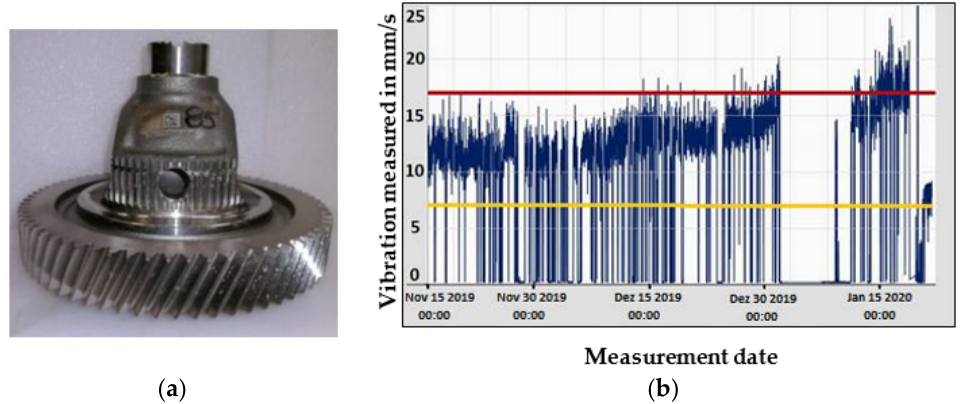
Figure 7. Renault Cacia differential box asset: ( a ) Differential box; ( b ) HESSAP machine status before the intervention.